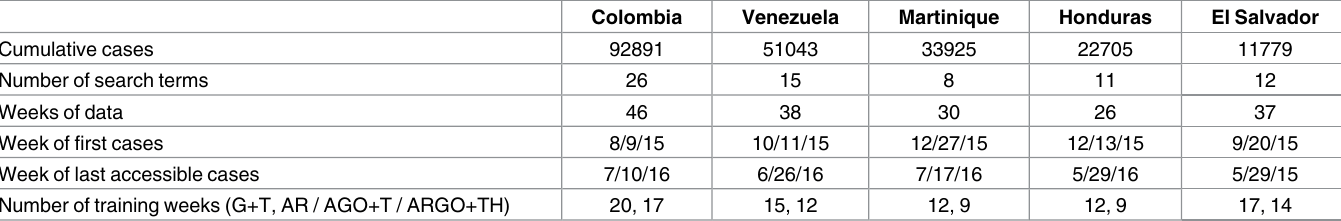
Table 1. Data profile for